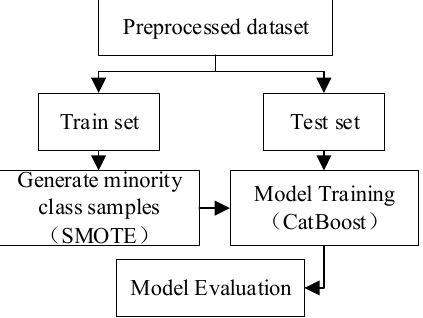
Figure 8. SMOTE-CatBoost model prediction process.